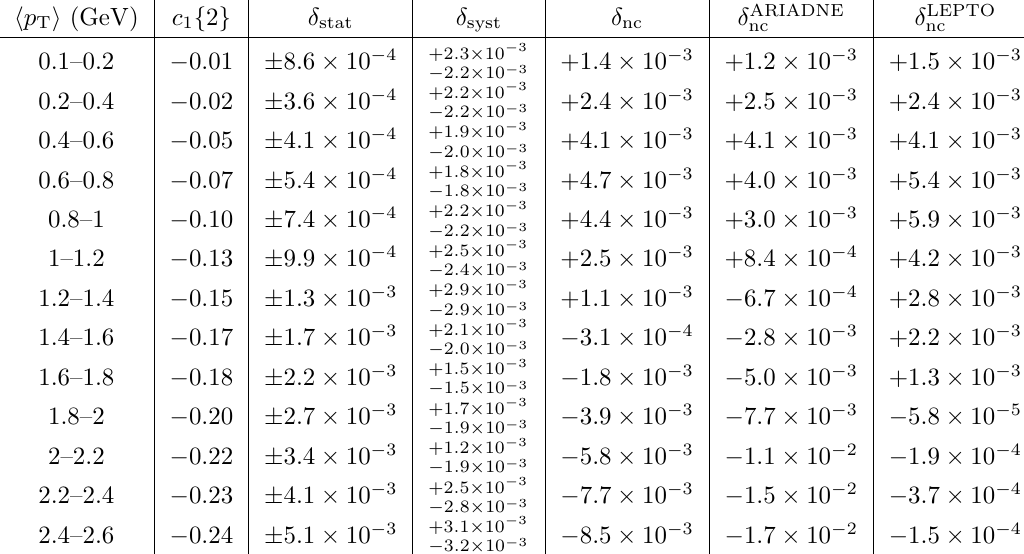
Table 21 . c 1 f 2 g versus h p T i from (cid:12)gure 9 (a), 15 (cid:20) N ch (cid:20) 30, p T > 0 : 1 GeV, j (cid:1) (cid:17) j > 2; (cid:14) stat , (cid:14) syst and (cid:14) nc denote the statistical, systematic and Monte Carlo non-closure uncertainties,